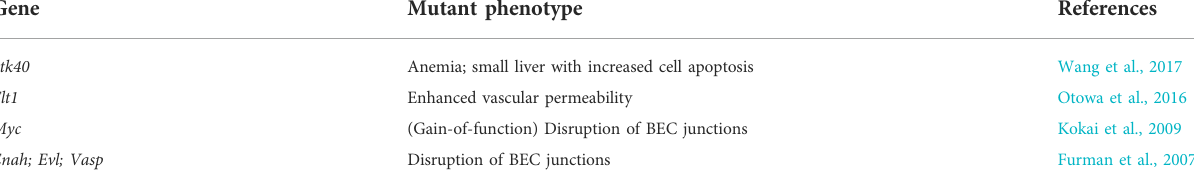
TABLE 3 List of genes and mutant phenotypes related to fetal nuchal edema with anemia or blood vascular endothelial barrier anomalies in mice (loss-of-function mutations if not stated).